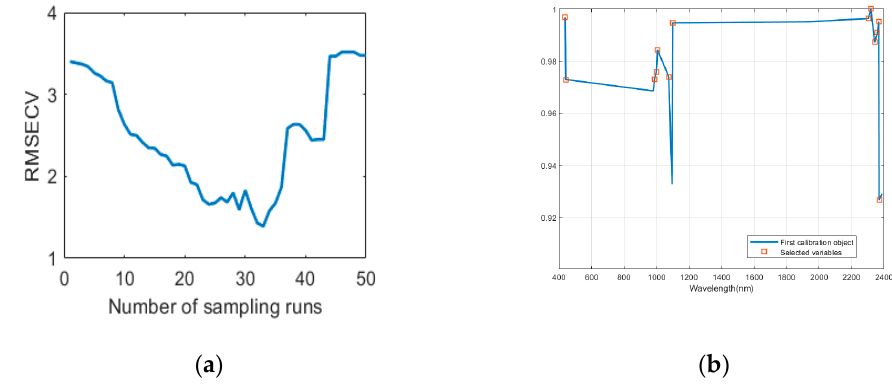
Figure 5. In Honghu area, the sCARS-SPA is used for characteristic wavelength selection: ( a ) the RMSE of the 5-fold cross-validation value changes with the number of sCARS algorithm sample runs; ( b ) the final characteristic wavelength and reflectance selected by SPA.